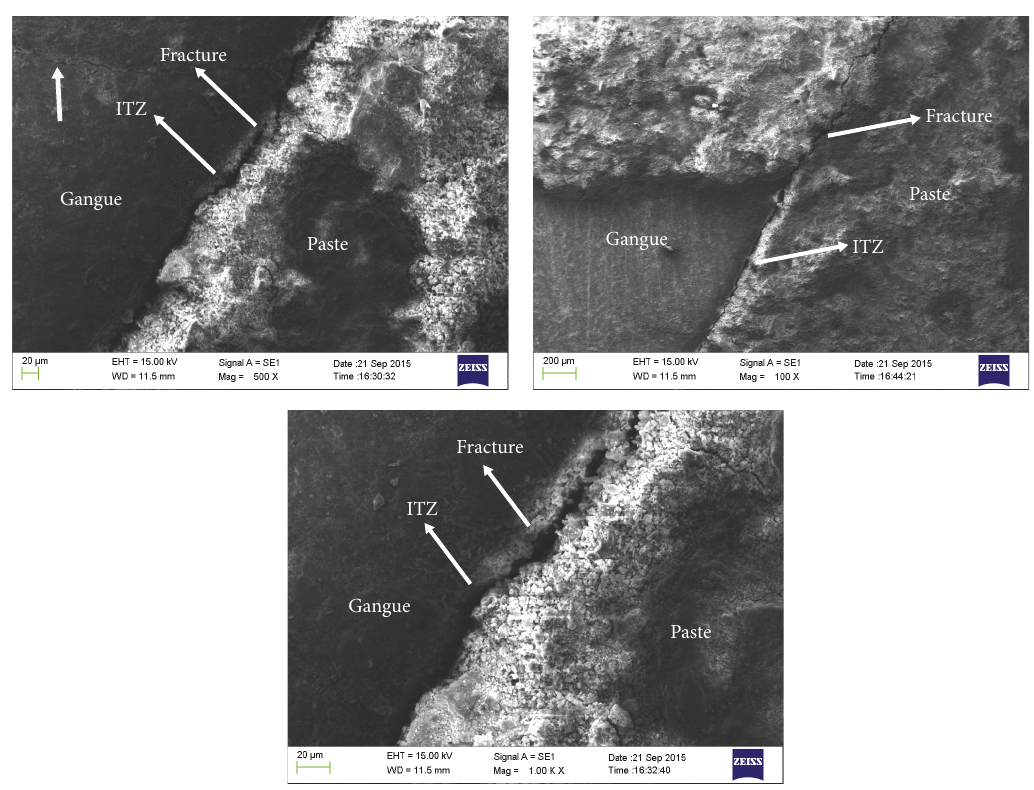
Figure 7: SEM photos of CGB sample under 𝜎 𝑏